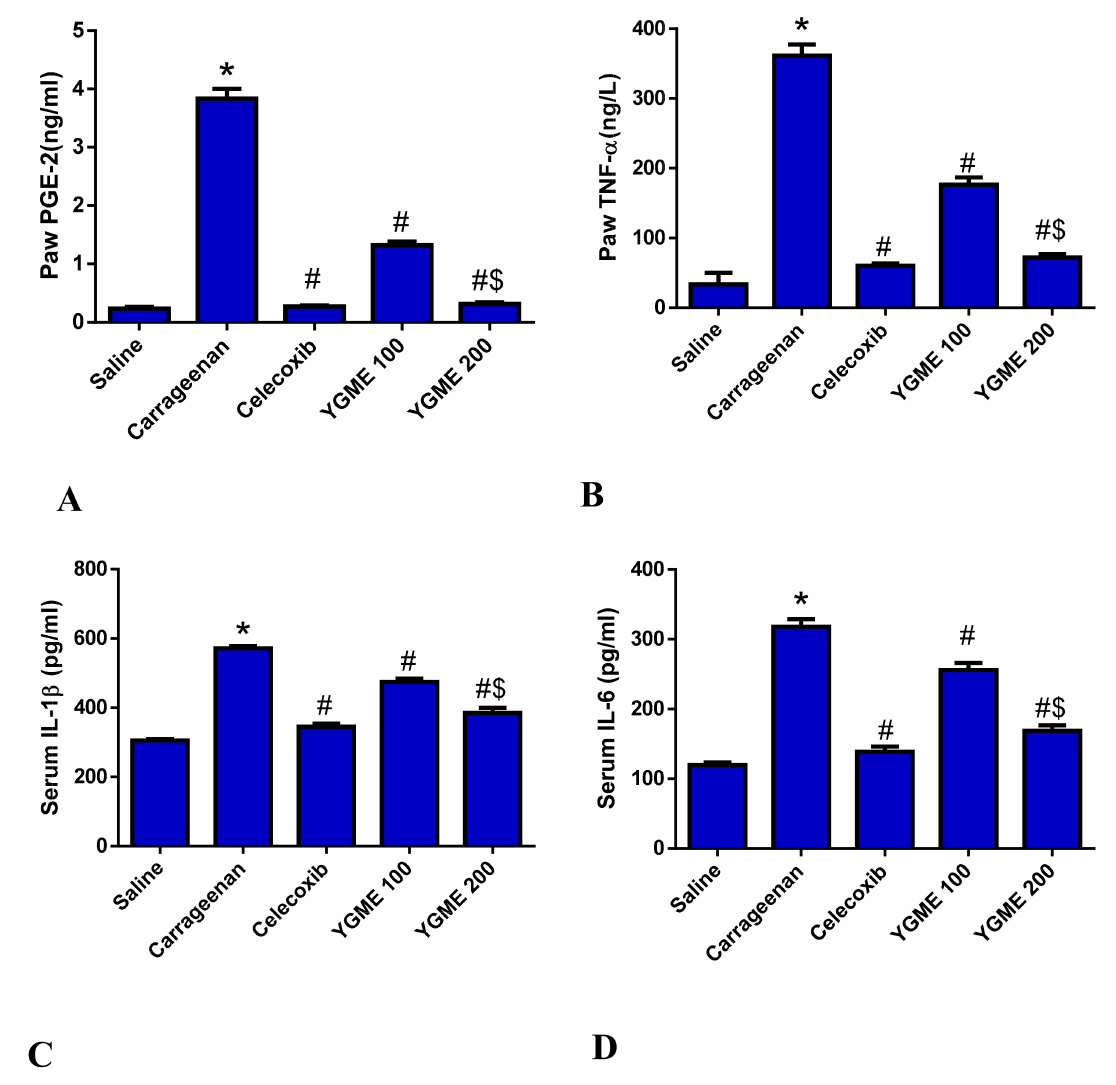
Figure 5. Drug treatment effects on ( A ) paw PGE-2 level, ( B ) paw TNF- α level, ( C ) serum IL-1 β level, ( D ) serum IL-6 level. Data expressed as mean ± SD ( n = 8/group). Significant difference vs. * respective control saline, # respective carrageenan group, $ respective YGME 100 group, each at p <